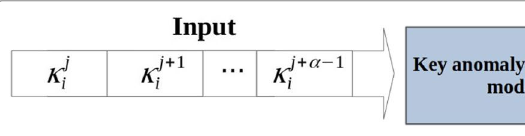
Fig. 5 The overview of our anomaly detection